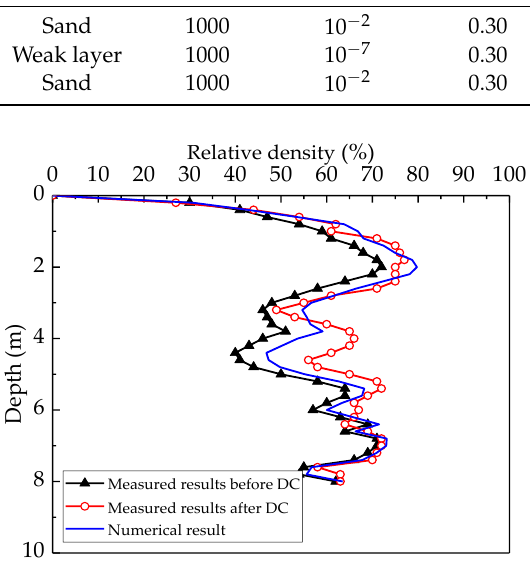
Figure 6. Comparison results of relative density [26].